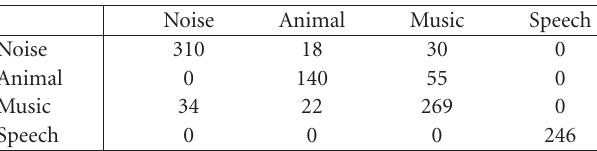
Table 6: Confusion matrix (rows give the decision and columns give the true class) for AM short with NN. This gave an accuracy of 82.56%.